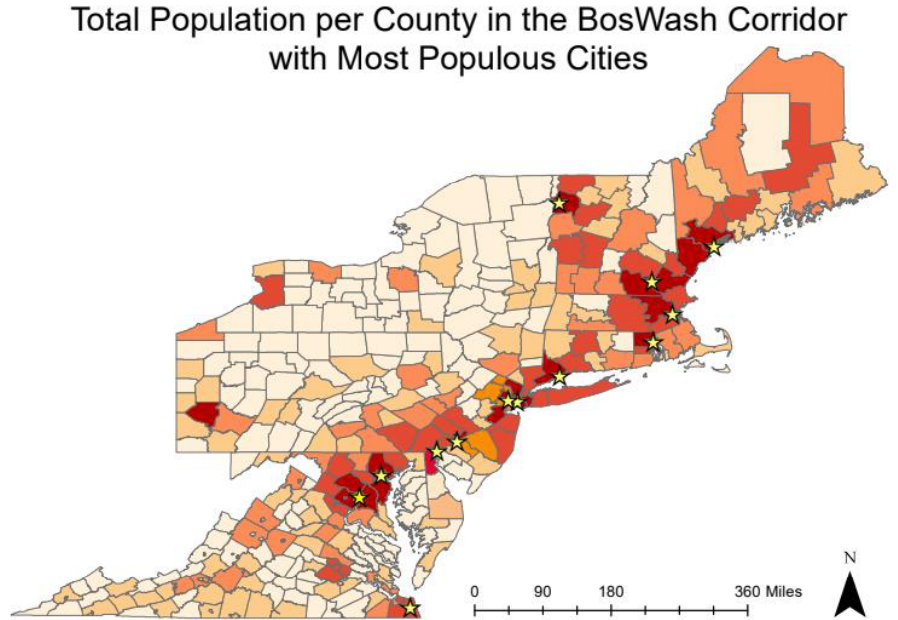
Figure 3. Population density by county across the 12 states in the BosWash corridor. Within each state, population densities are broken into 5 classes using natural break (Jenks), which maximizes the difference between classes. Populations vary dramatically across counties within the BosWash corridor so natural breaks for each state were chosen to demonstrate regional population trends. Yellow stars identify the location of the most populous cities within each state and Washington, DC [72]. Areas of dense population across the region are highlighted and define the cities chosen for analysis. Cities chosen for analysis are marked with a yellow star.